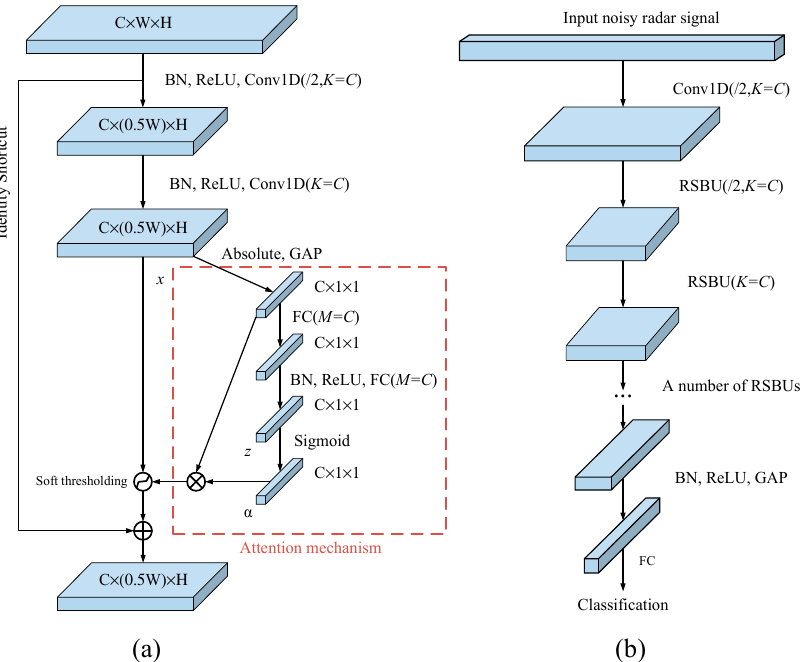
Figure 3. The 1D DRSN structure, ( a ) 1D residual shrinkage building unit (RSBU), and ( b ) overall framework.